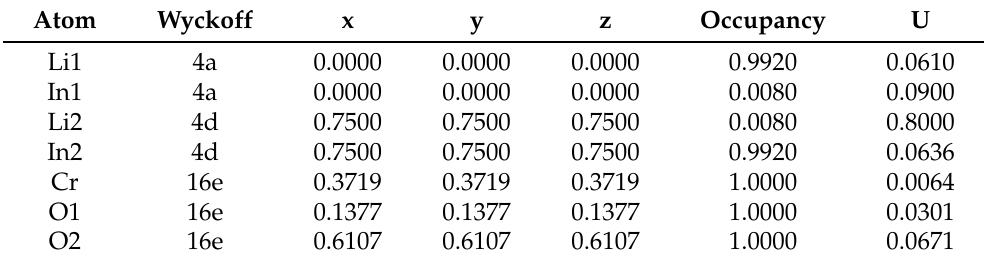
Table 5. The Wyckoff sites, fractional coordinates, and occupations as reported in an earlier study [5] and the thermal parameter U as obtained from Rietveld refinement of LiInCr 4 O 8 in the ambient structure at ∼ 14 GPa. Space group F¯43m, Z = 4, a = 8.2624(13) Å and V = 564.05(26) Å 3 .